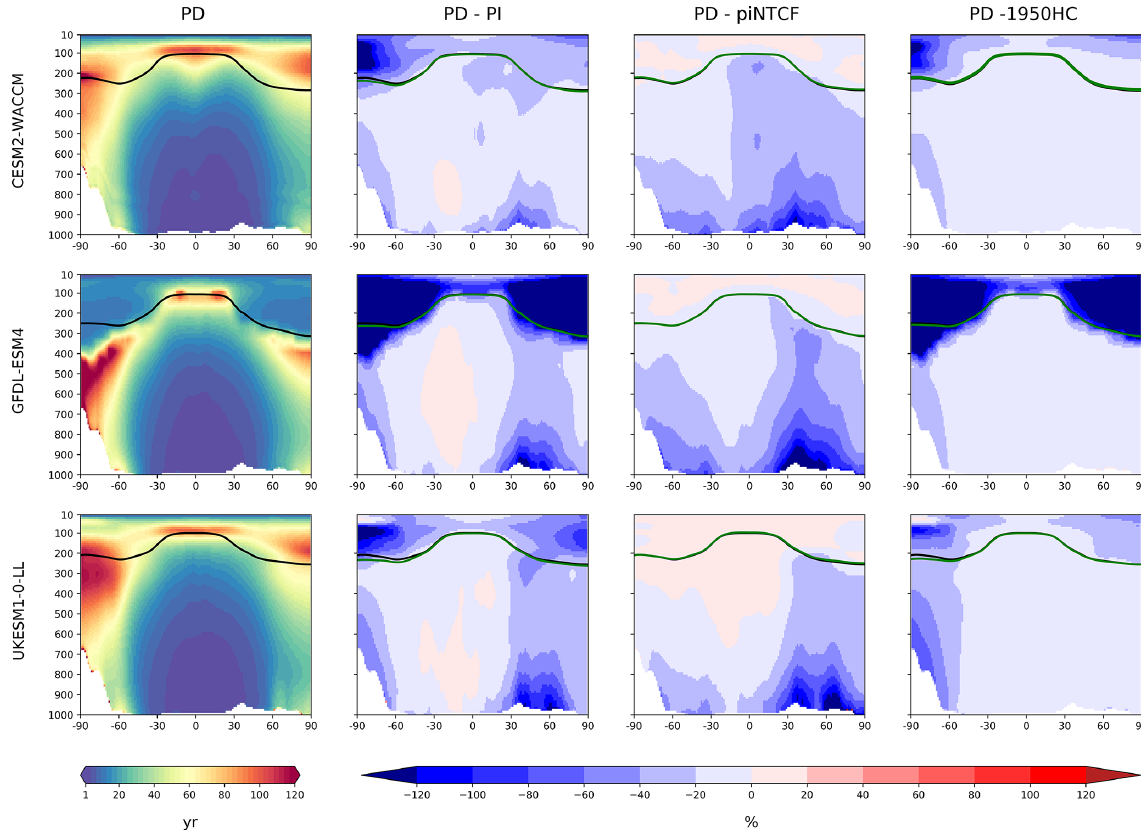
Figure 4. The same layout as Fig. 3, but for CH 4 lifetime